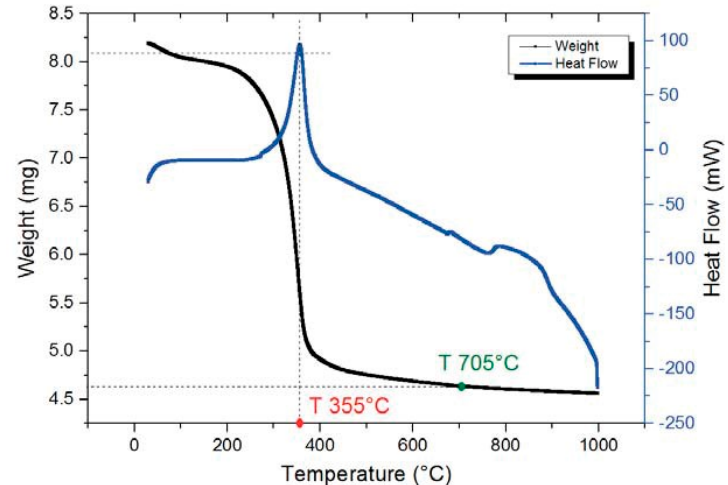
Figure 1. TGA-DSC analysis of Ni 3 V 2 O 8 precursor.